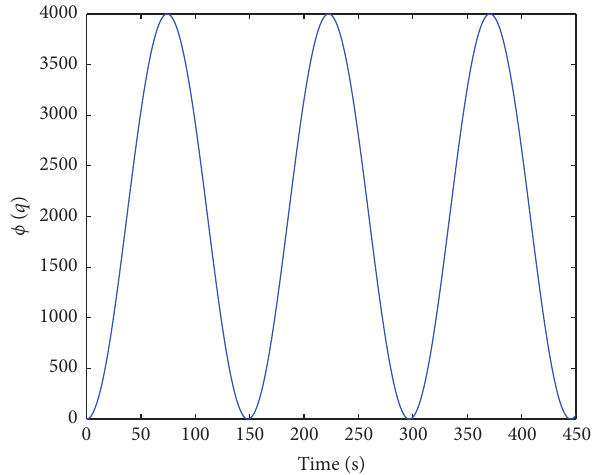
Figure 2: The evolution of road-friction coefficient on L .